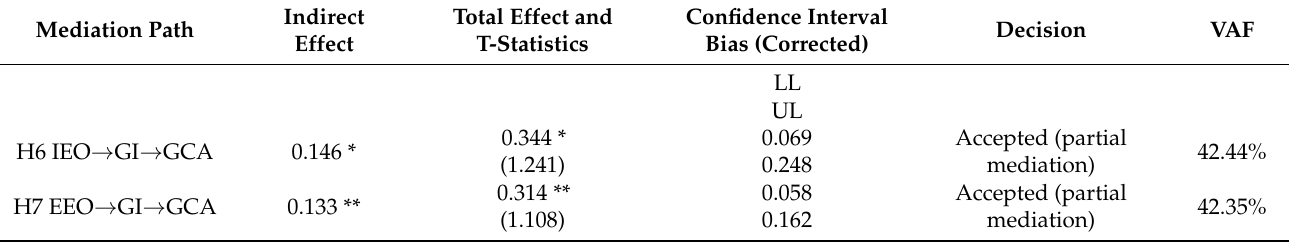
Table 5. Mediation